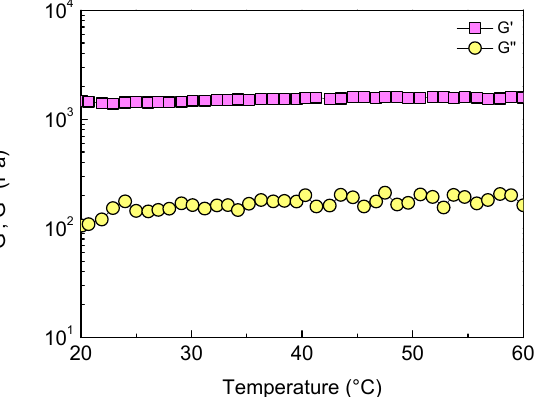
Figure 3. Storage (G’) and loss (G”) modulus as a function of Temperature (1 °C/min) of a PAA-g- P(boc-LL) aqueous solution of C p (1 wt%) at pH 8.8.